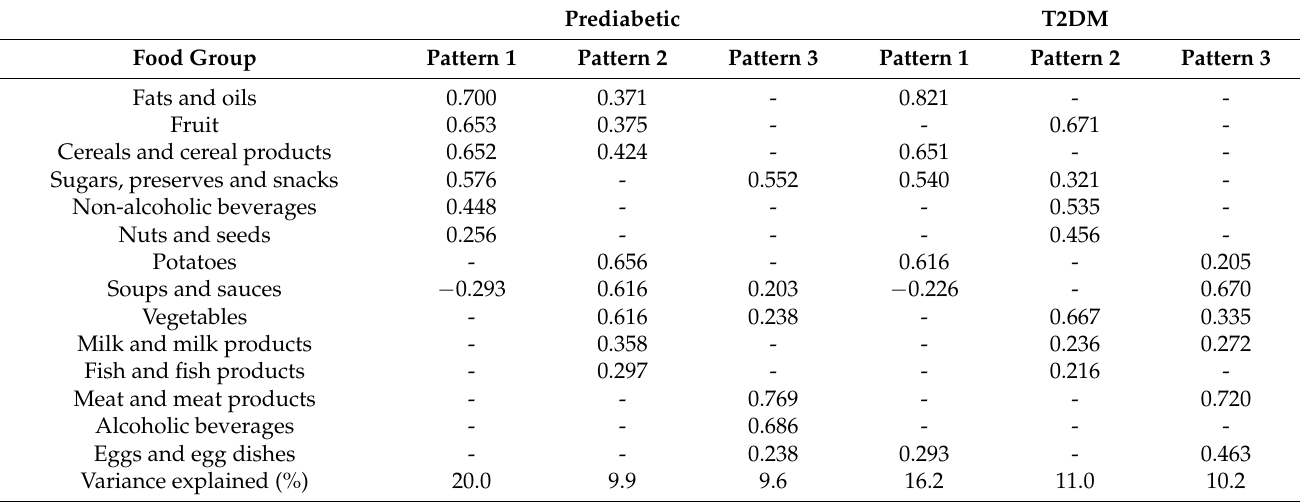
Table 3. Factor loading matrix for main dietary patterns of prediabetic and type 2 diabetes